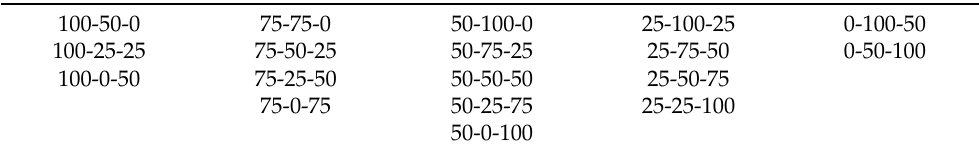
Table 1. Possible cases consisting of 3 BGs that meet the 50% office space—50% multifunctional atrium requirement for the whole